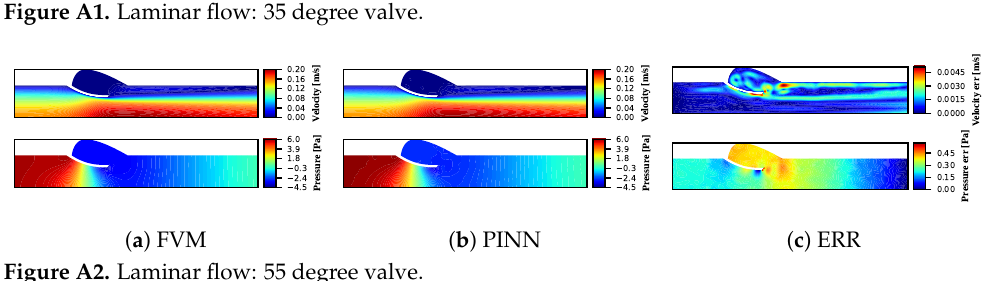
Figure A2. Laminar flow: 55 degree valve.